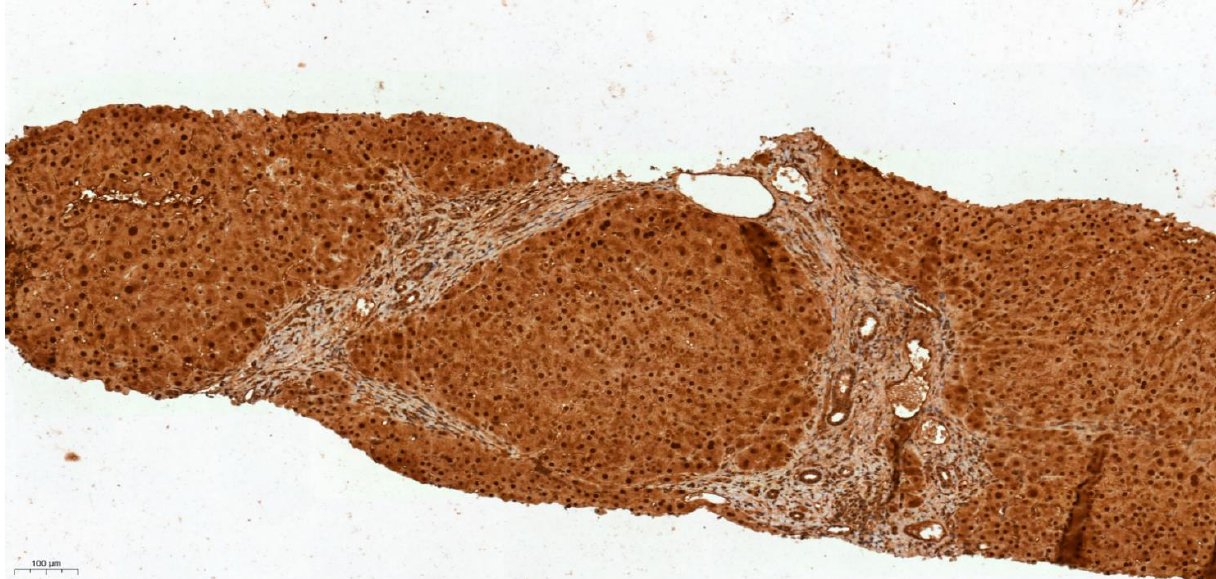
Figure 4. IHC characteristics of kallikrein-6 (KLK6) in liver cirrhosis at low power magnification ( × 10). The brown chromogen indicated protein expression of KLK6 in the nucleus and cytoplasm of the hepatic and stromal cells. The slide shows a section of a cirrhotic liver showing well defined nodules of regenerating hepatocytes with expanded fibrotic portal tracts without marked nuclear atypia — demonstrating moderate intensity of nuclear and cytoplasmic staining for KLK 6 (Allred score 2).